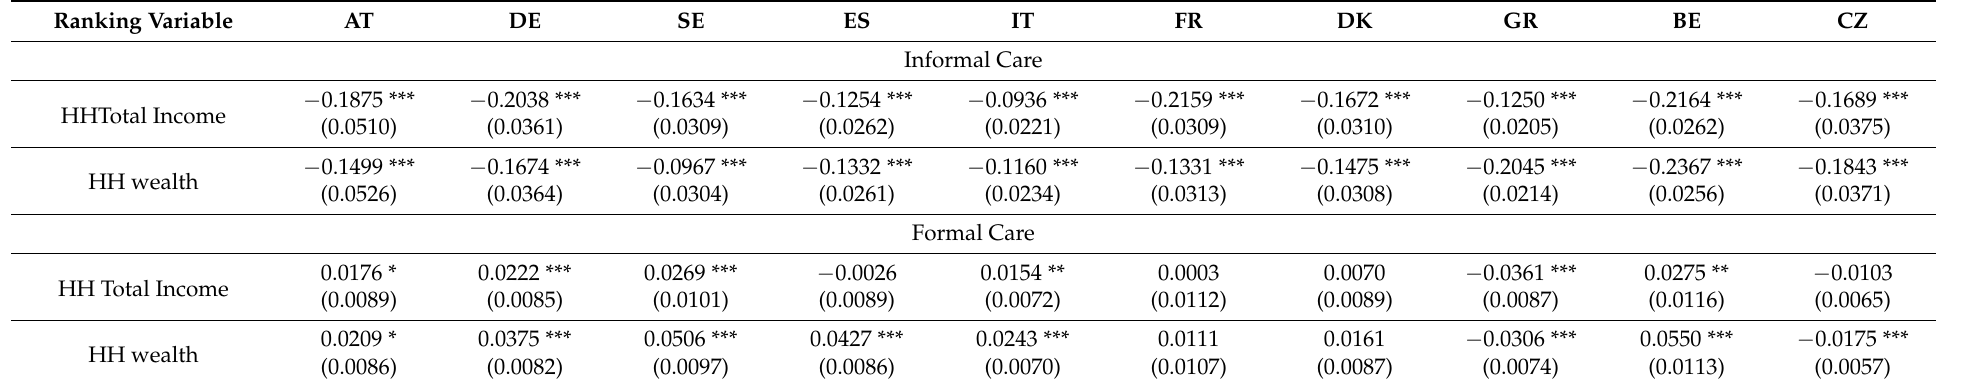
Table 4. Inequality in the use of long-term care (LTC).